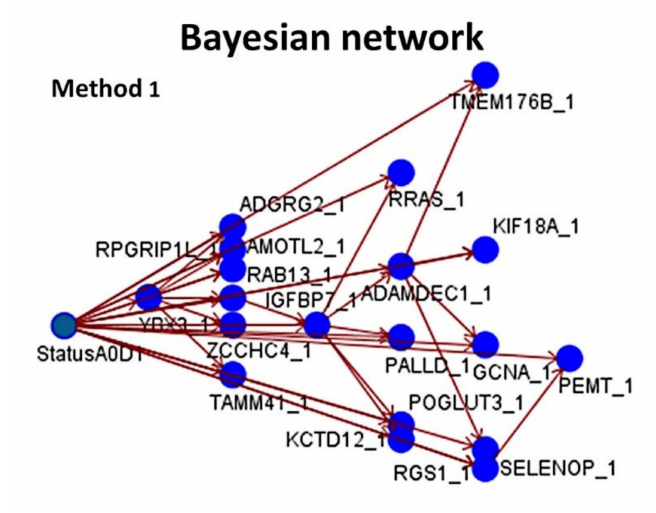
Figure 11. Bayesian network. A Bayesian network successfully modeled the overall survival outcome (dead/alive) using the 19 genes, previously identified in the neural network analysis (Figure 5, Method 1). The Bayesian network enables you to build a probability model by combining observed and recorded evidence with “common-sense” real-world knowledge to establish the likelihood of occurrences by using seemingly unlinked attributes. The node focuses on Tree Augmented Naïve Bayes (TAN) and Markov Blanket networks that are primarily used for classification. This graphical model shows the variables (nodes) and the probabilistic, or conditional, independencies between them. The links of the network (arcs) may represent causal relationships, but the links do not necessary represent direct cause and effect. This Bayesian network is used to calculate the probability of a patient of being alive or dead, given the gene expression of 19 genes, if the probabilistic independencies between the gene expression and the overall survival outcome as displayed on the graph hold